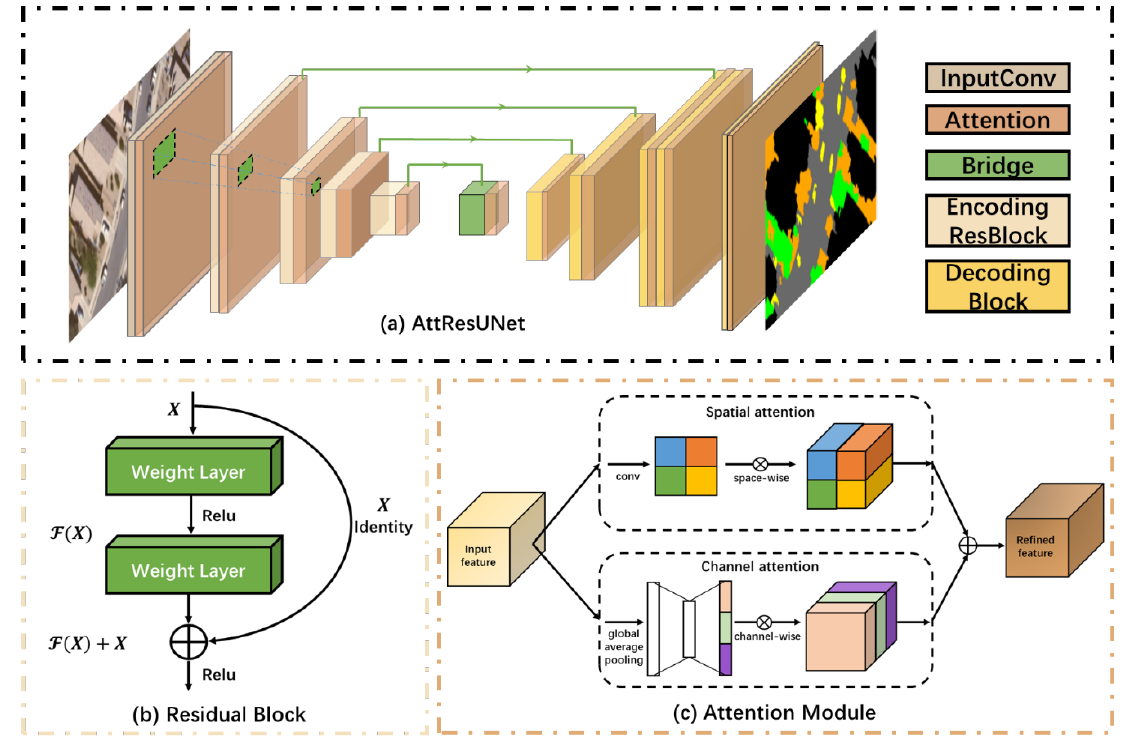
Figure 2. The architecture of AttResUNet. The proposed DSSN ( a ) has U-shaped architecture using residual blocks ( b ) to encode feature maps and attention module ( c ) to refine the features.